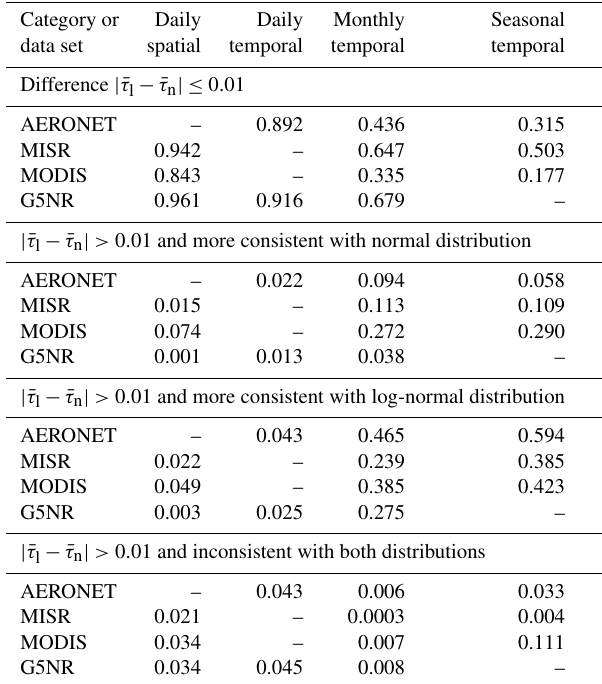
Table 1. Mean fraction of data falling into the four categories of SW test